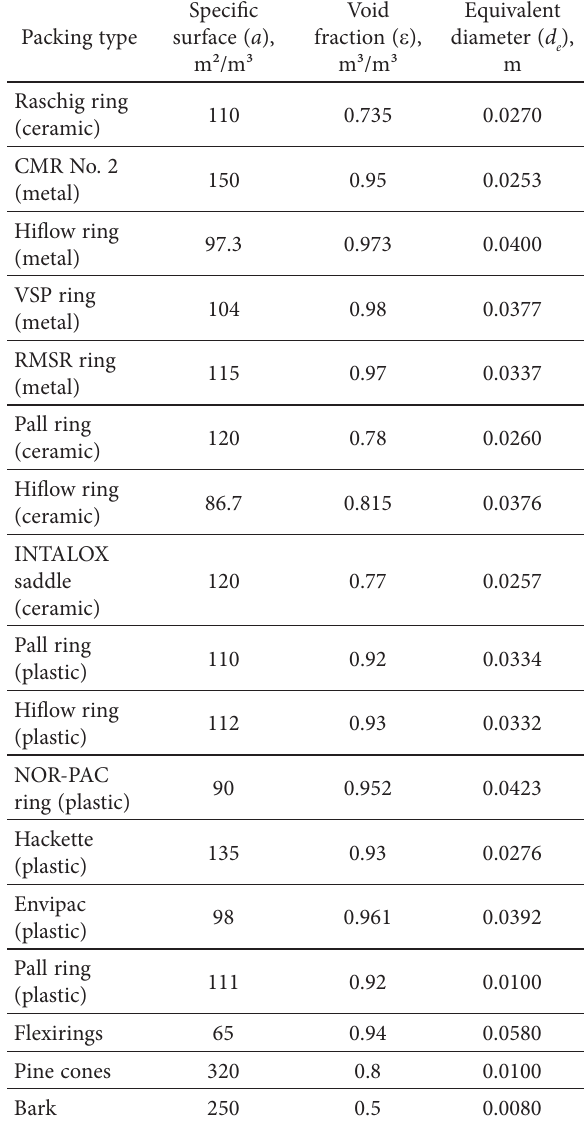
Table 3. Geometric characteristics of random packing (the typical size is 50